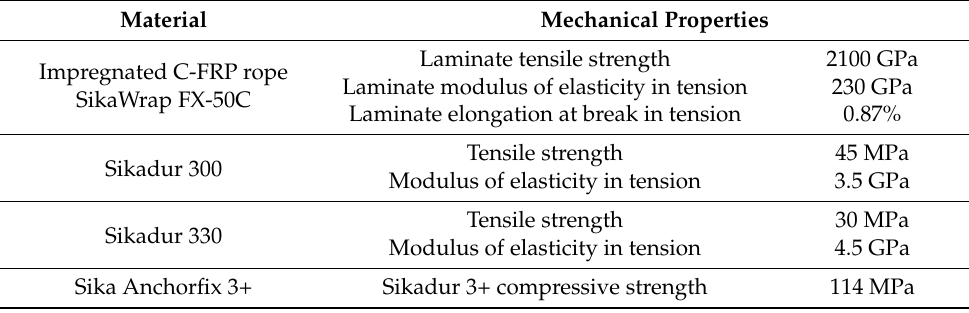
Table 1. Mechanical properties of strengthened materials.